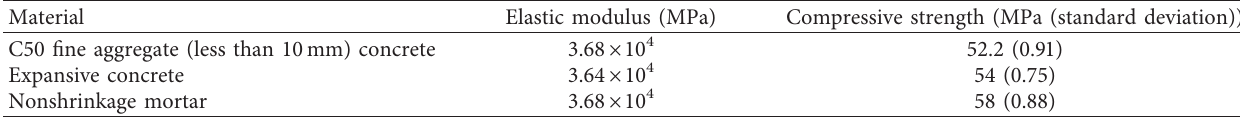
Table 2: Material properties of concrete.